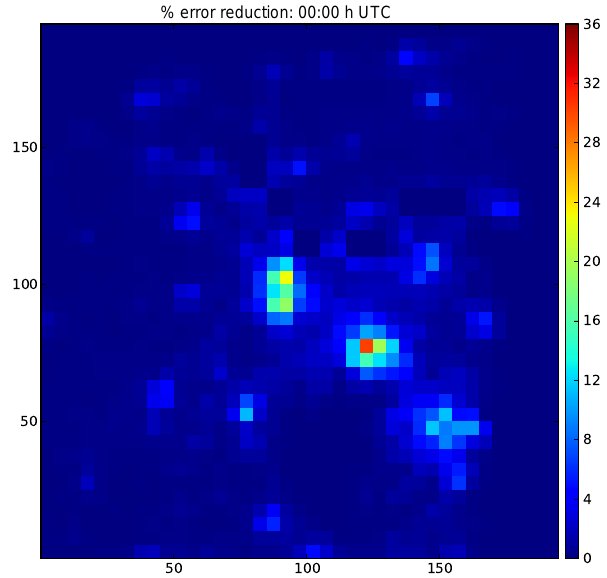
Figure 12. Spatial distribution of E , the reduction in uncertainty in the CO 2 flux, at 00:00UTC as determined using both X CO X CO data.